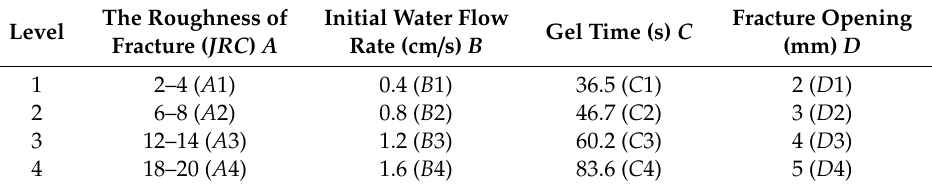
Table 1. The four factors and four levels used in the experiment.